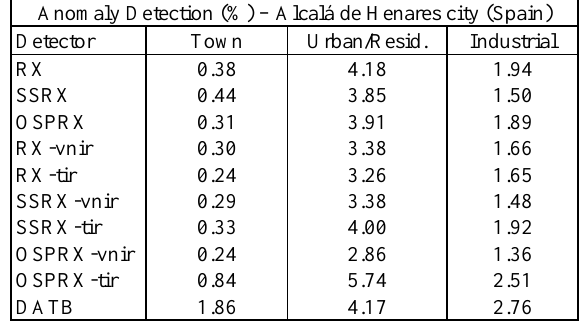
Table 1. Comparison of results (anomalies %) between anomaly detectors for Alcalá de Henares city in relation with the full scene (580563 pixels).